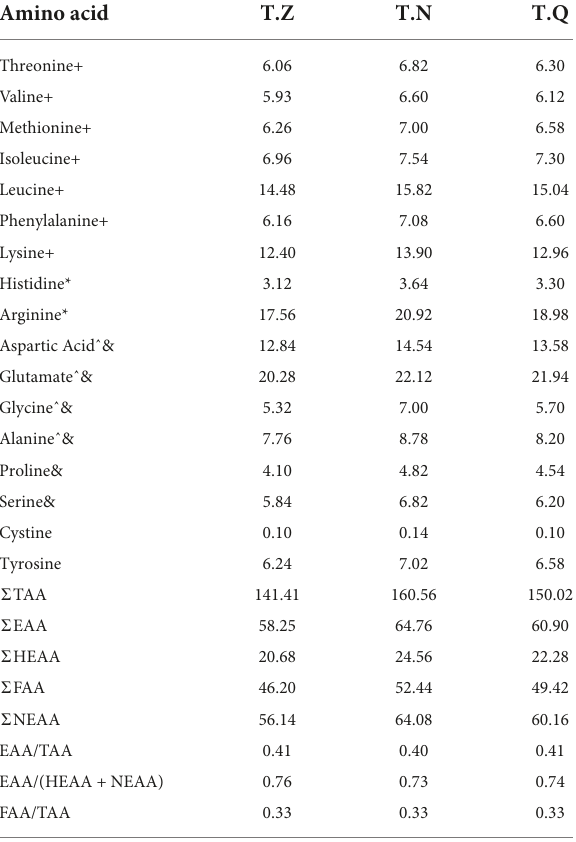
TABLE 3 The amino acids composition in muscle of hairtail (mg · g − 1 ). Amino acid